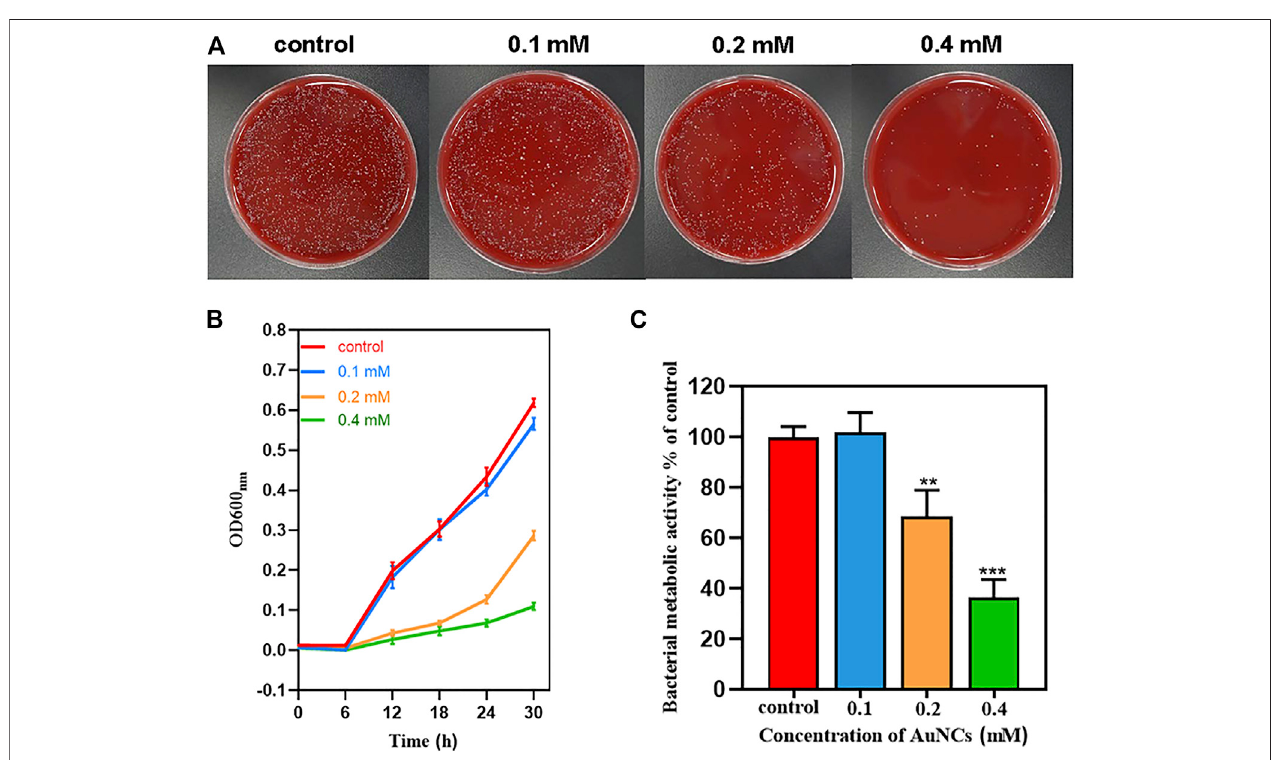
FIGURE 2 | Antibacterial effects of AuNCs against F. nucleatum . (A) Growth inhibition of AuNCs (0.1, 0.2, and 0.4 mM) against F. nucleatum at 6 h on blood agar plates. (B) Growthcurvesof F.nucleatum exposedtoAuNCs(0.1,0.2,and0.4 mM)for30 h. (C) Bacterialmetabolicactivityof F.nucleatum exposedtoAuNCs(0.1,0.2, and 0.4 mM for 6 h (**P < 0.01, ***P < 0.001).